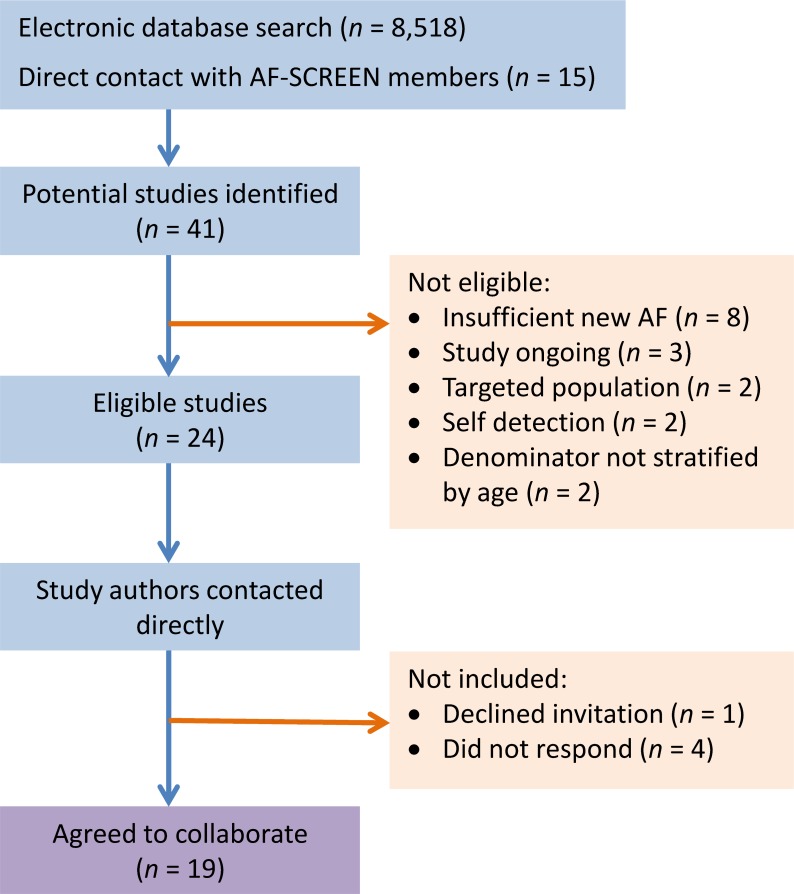
Study selection.